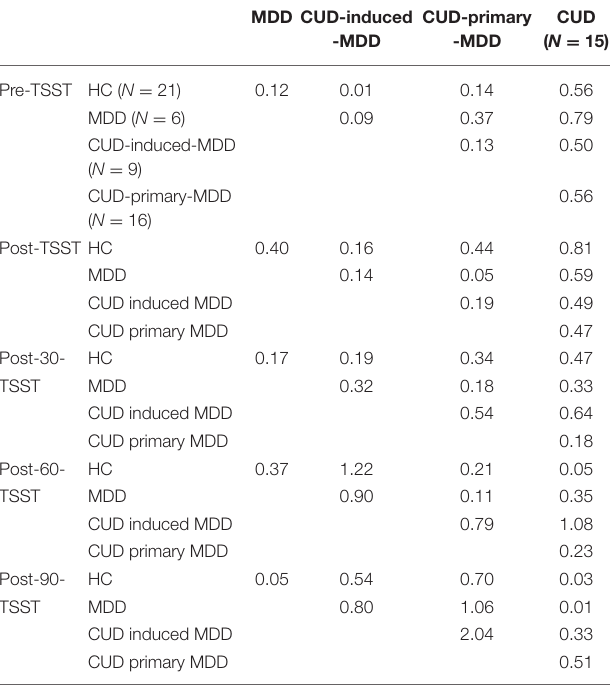
TABLE 3 | Effect size coefficient (Cohen’s d) pairwise comparisons of cortisol concentrations in each assessment.